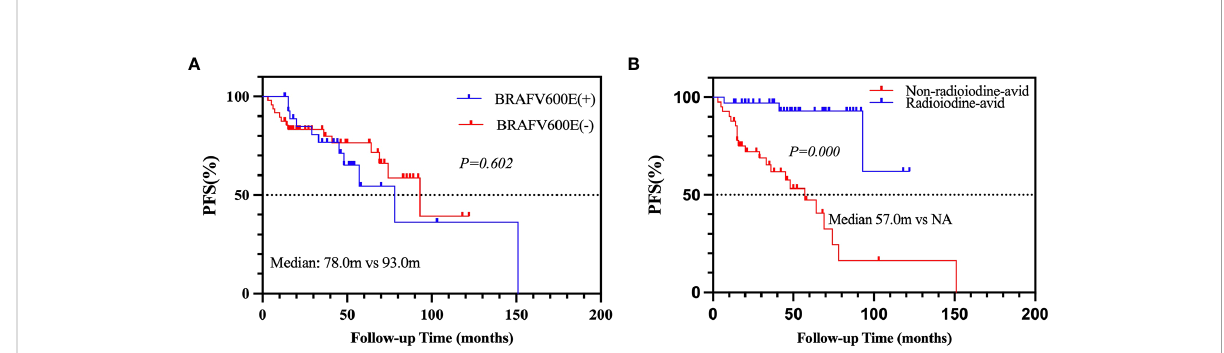
FIGURE 2 Kaplan – Meier analysis of PFS in PTC patients according to BRAF V600E mutation status (A) and radioiodine avidity status (B) . PFS, progression- free survival; PTC, papillary thyroid cancer.